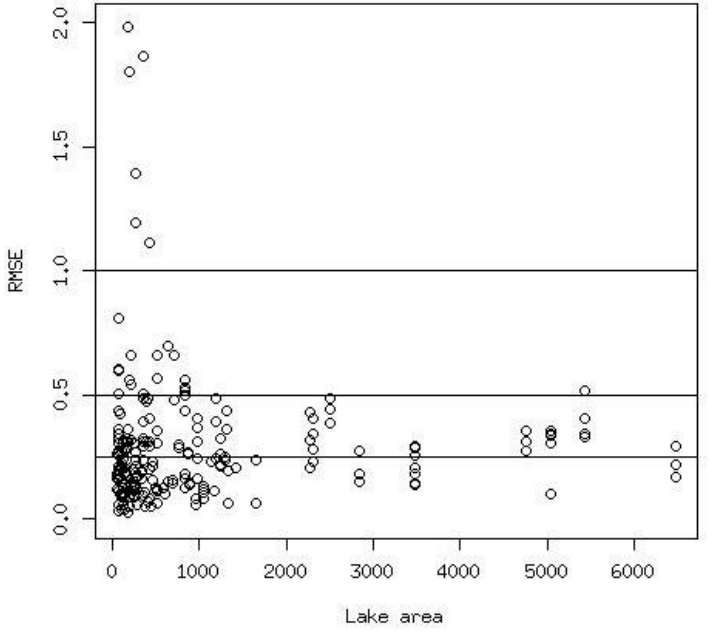
Figure A5. Scatter plot of the RMSE as a function of lake area. The function of the horizontal lines is only to make the relation more